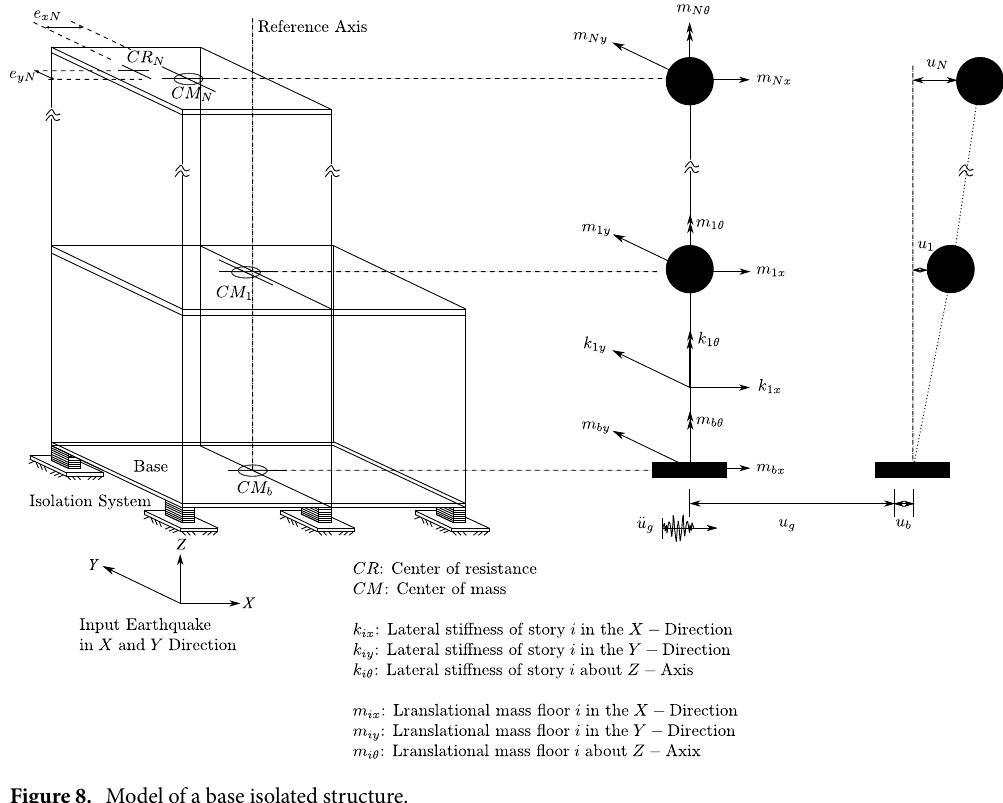
Figure 8. Model of a base isolated